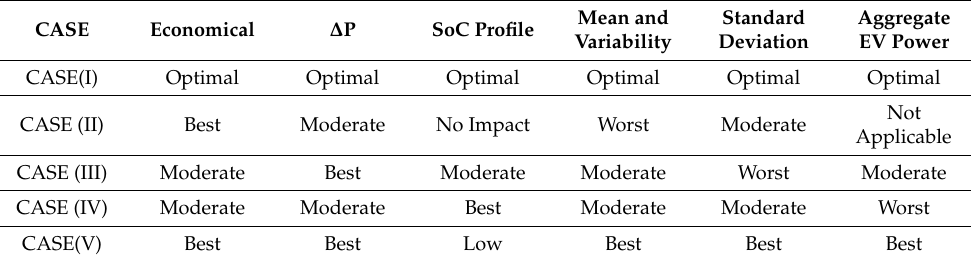
Figure 16. Aggregate power availabilities of EVs in various cases. Table 7. Comparative analysis of various cases of different